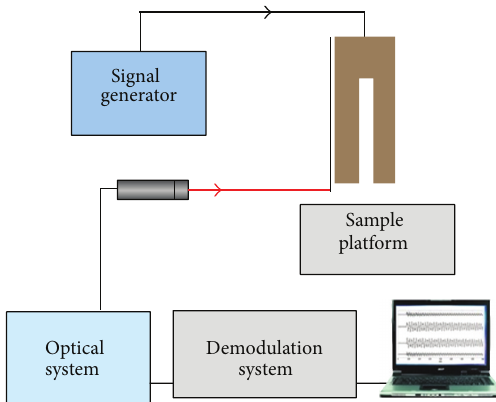
Figure 11: Schematic diagram of single-point LDV based tuning fork probe assembled